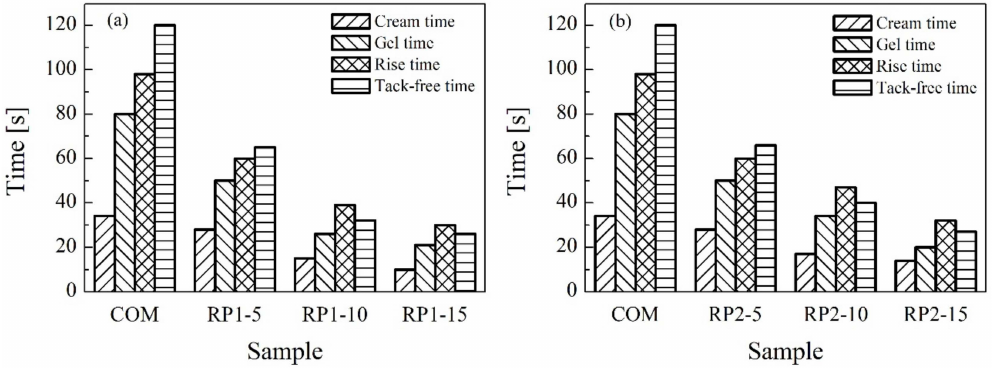
Figure 7. Characteristic times in reactions with ( a ) RP1 and ( b )